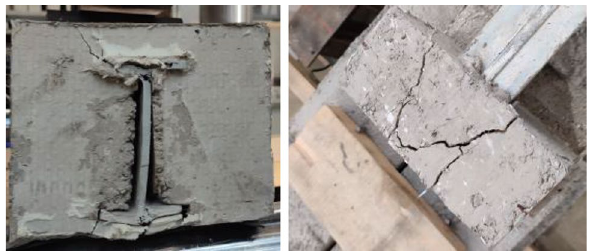
Figure 8. The typical failure of the support block of the first series beam.